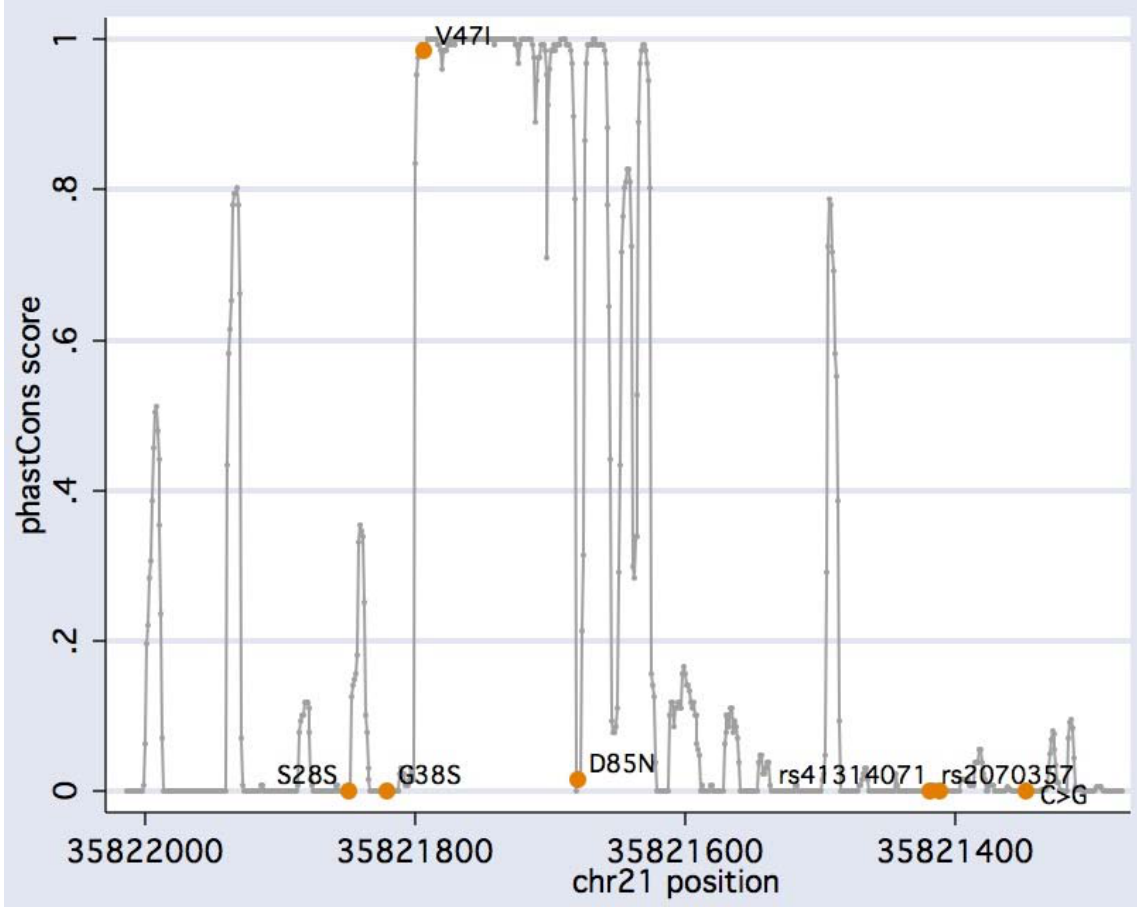
Figure 3. Comparative analysis of the KCNE1 genomic sequence screened. Basewise conservation scores obtained with the Multiz alignment are plotted against the physical position on chromosome 21 for 31 placental mammals featured in the UCSC Genome Browser. The newly identified V47I mutation maps to the highly conserved KCNE1 transmembrane domain delimited by residues 44 and 60